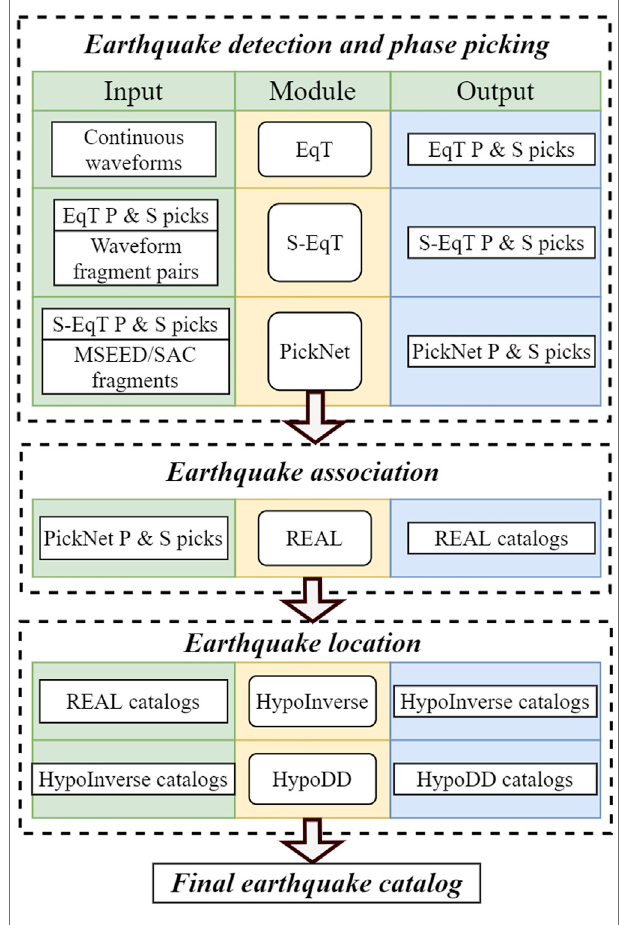
FIGURE 1 | Diagram of the ESPRH work fl ow.